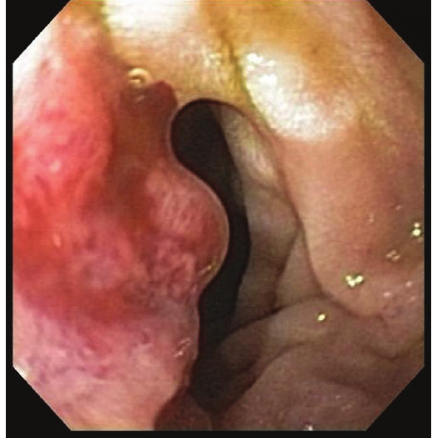
Figure 4: Duodenal mass.